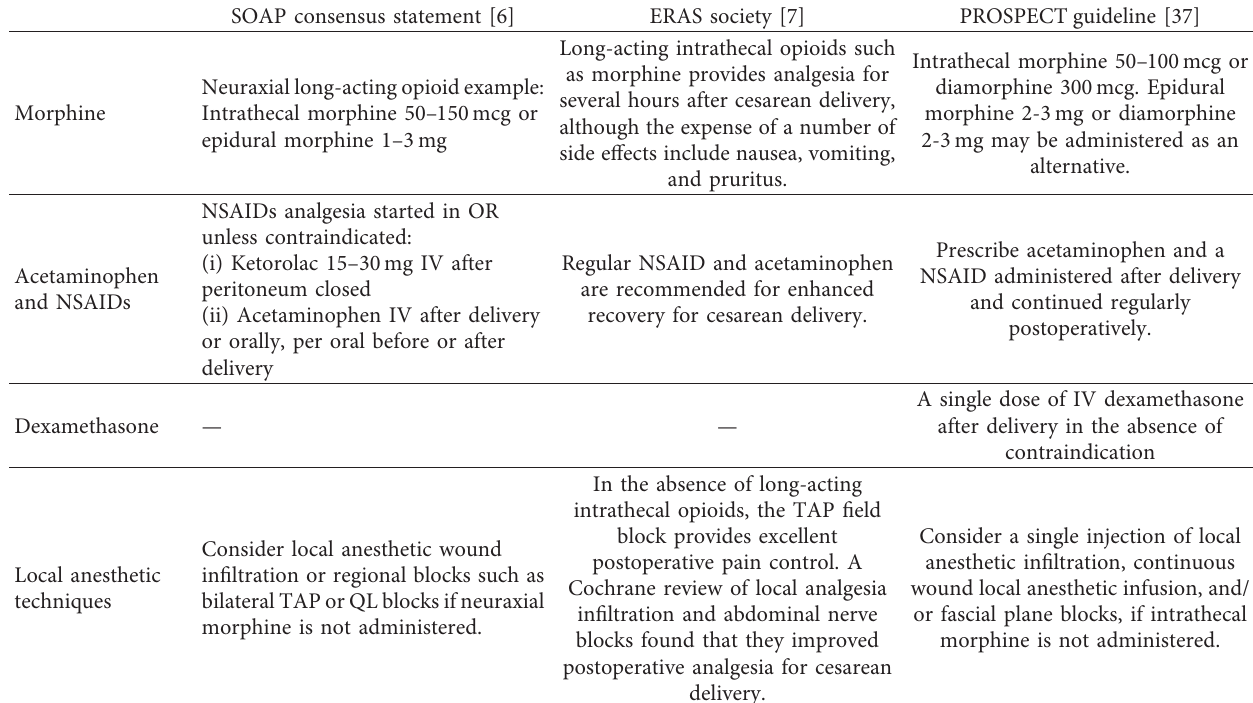
Table 5: Postoperative analgesic recommendation for cesarean